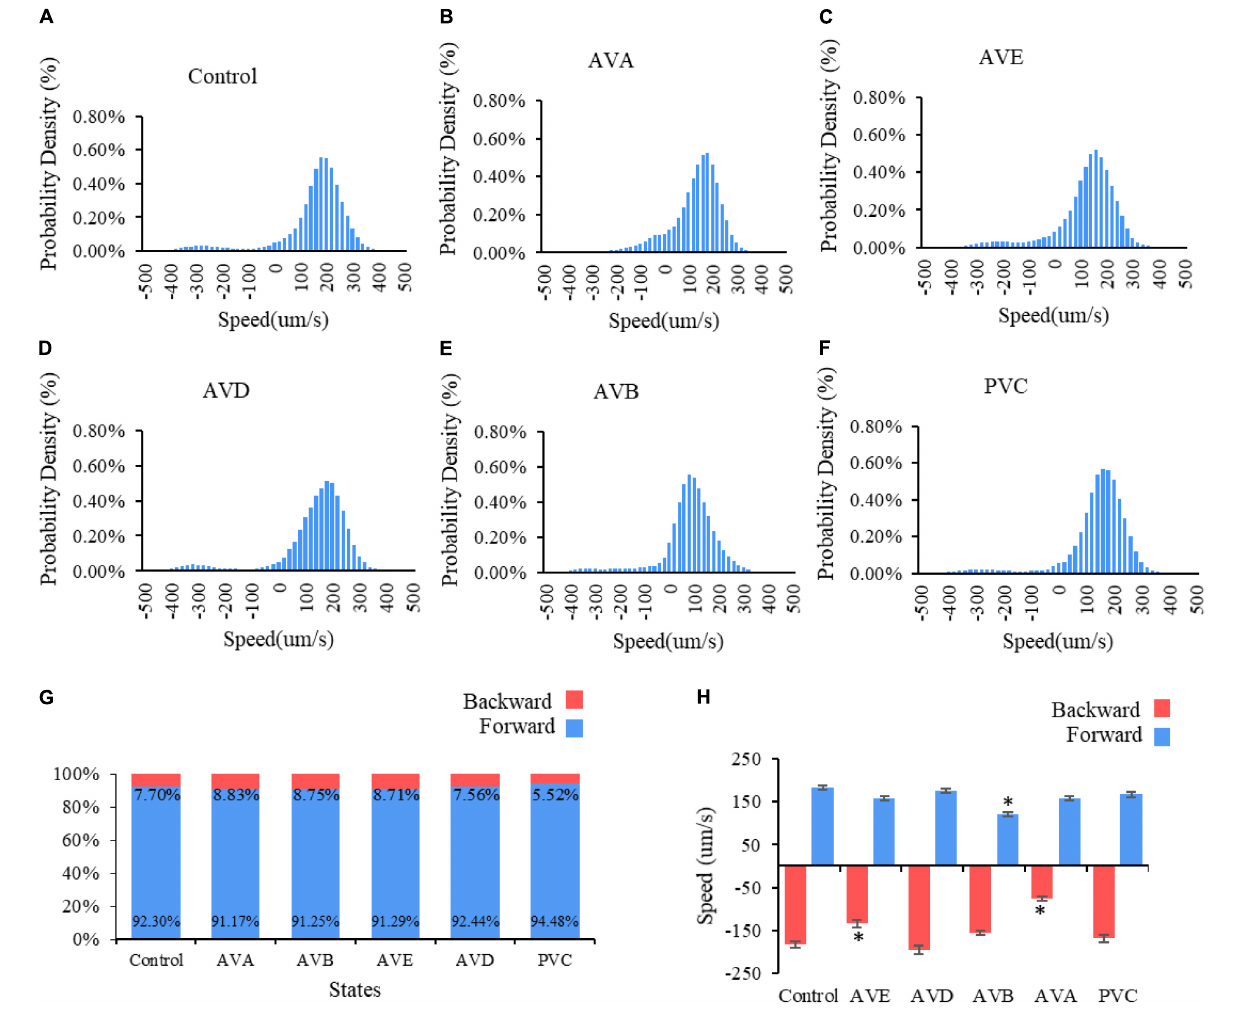
FIGURE 6 | Two locomotory states in C. elegans movement: forward and backward. Probability density of speed distribution for C. elegans (A) without neuro impairment, bin size = 20; (B) with AVD impairment, bin size = 20; (C) with PVC impairment, bin size = 20; (D) with AVA impairment, bin size = 20; (E) with AVE impairment, bin size = 20. Panel (F) with AVB impairment, bin size = 19. (G) The percentage of two locomotory states. (H) Average velocity of two locomotory states. * means significantly different from control